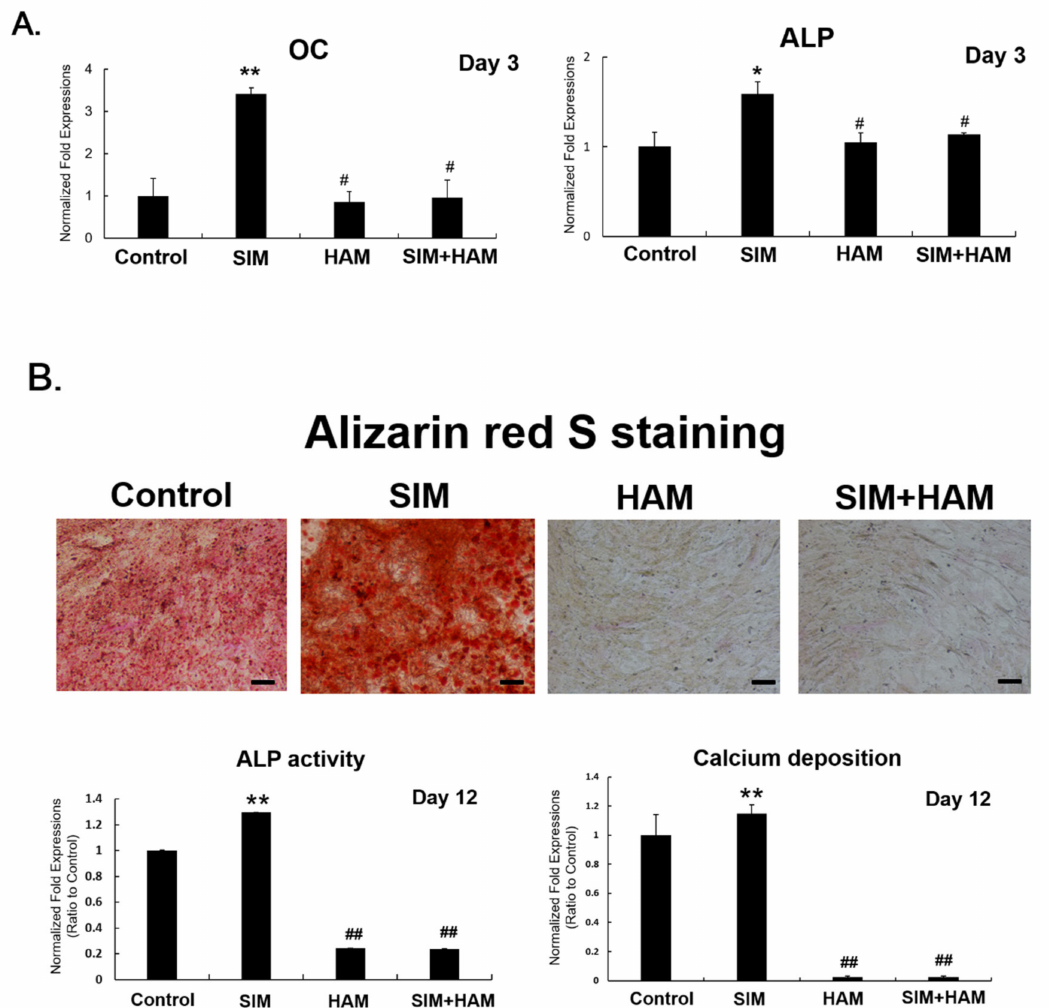
Figure 2. SIM plus HAM reduces the osteogenesis of ADSCs. ADSCs were treated with SIM and cultured in wells with/without an HA coating in basal medium, and the osteogenesis of ADSCs was analyzed. ( A ) The mRNA expression levels of osteogenic genes (osteocalcin; OC and alkaline phosphatase; ALP) in the control, SIM, HAM and SIM+HAM groups on day 3. The gene expression levels are expressed relative to those in the control group, which are defined as 1. ( B ) ADSCs were treated with SIM and cultured in wells with/without an HA coating in osteogenic medium, and the mineralization of ADSCs was analyzed. ALP activity and Alizarin red S staining of calcium deposition were performed on day 12. Red: Alizarin red S staining. The abundance of ALP activity and calcium deposition are expressed relative to that in the control group on day 12, which is defined as 1. The values presented are the means ± SEMs ( n = 6). (*) and (**) indicate p < 0.05 and p < 0.01, respectively, compared with the control group. (#) and (##) indicate p < 0.05 and p < 0.01, respectively, compared with the SIM